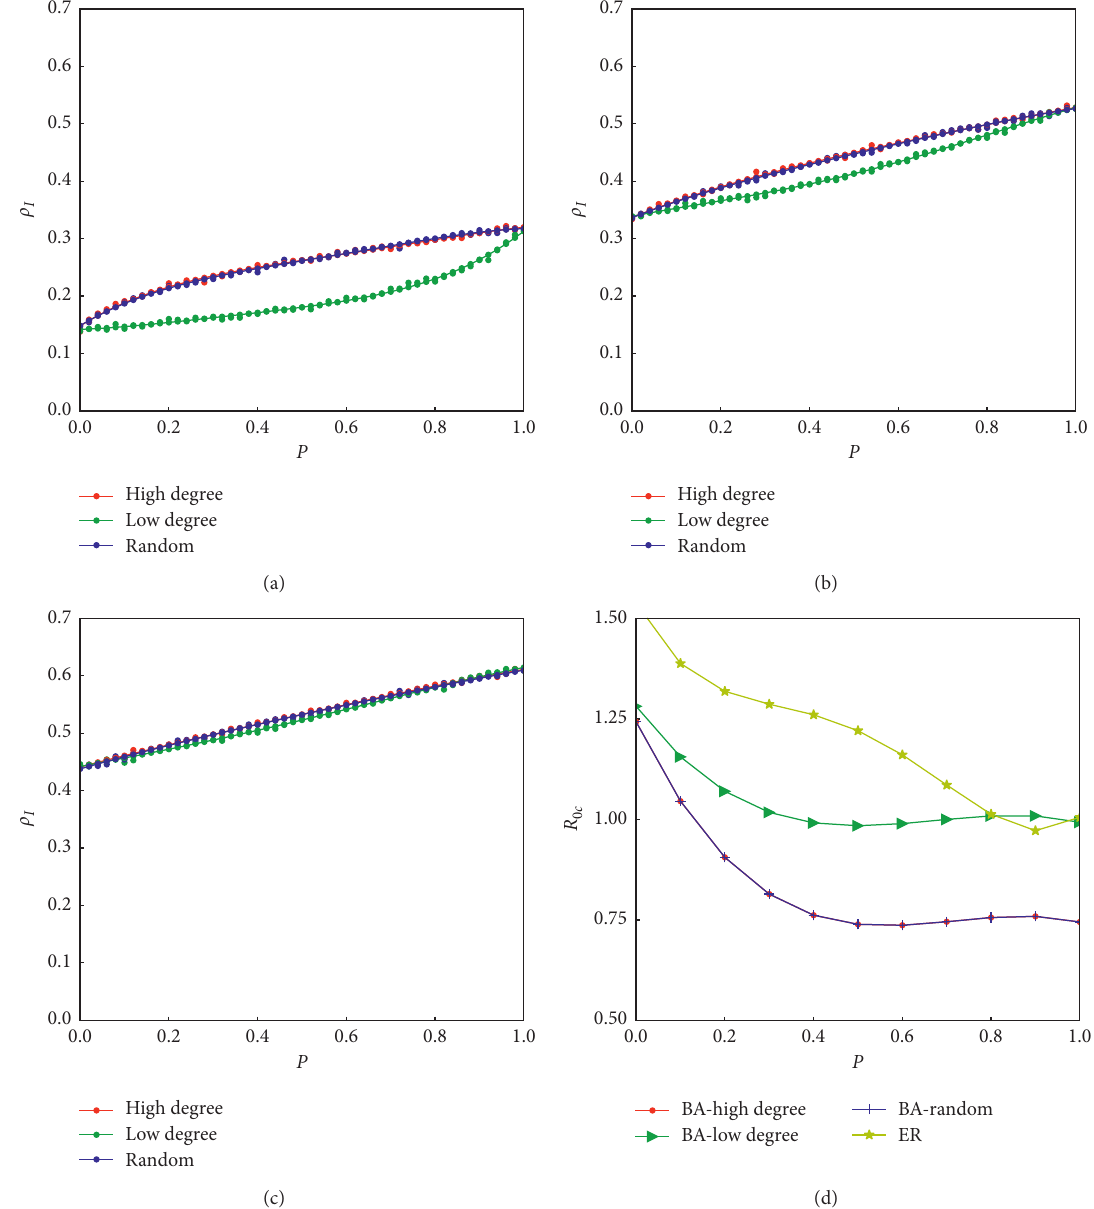
Figure 8: For the first form of dependence, where c � ( 1 − ρ dependence of epidemic prevalence ρ I on the ratio of irrational individuals on the BA scale-free network for (a) R � 3 . 75. Irrational individuals are distributed according to three different strategies: on nodes with the highest degree (red line), on (c) R 0 nodes with the lowest degree (green line), and randomly distributed (blue line). (d) The critical infection rate R different situations. The parameters are the same as those in Figures 4 and